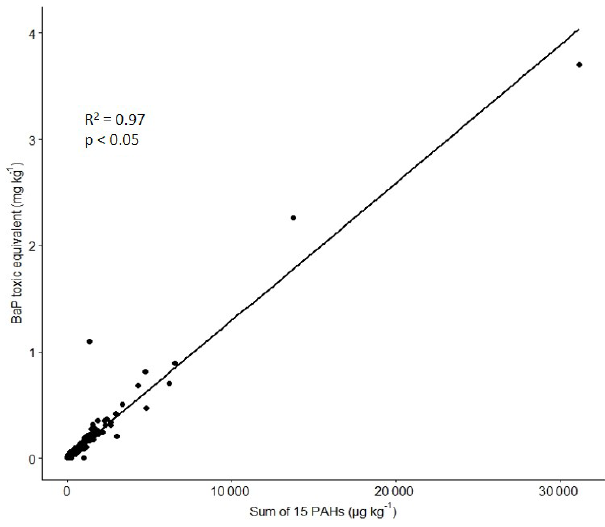
Figure 4. Correlation between the BaPeq in milligrams per kilo- gram and the concentration of the (cid:54) 15 PAHs in micrograms per kilogram in French